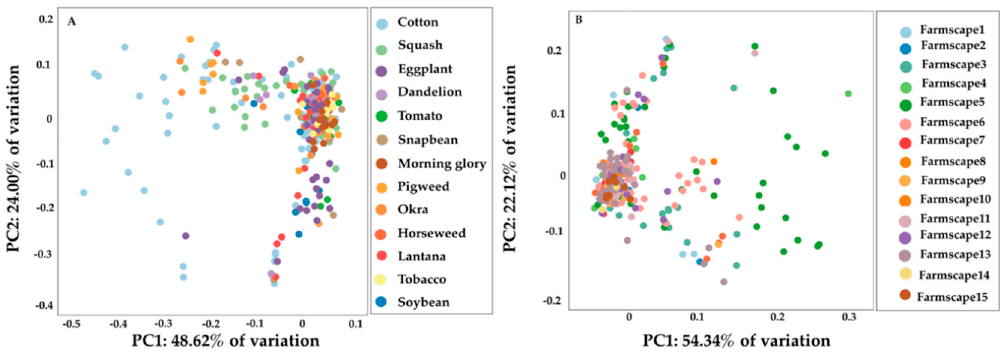
Figure 5. Population structure based on principal component analysis for B. tabaci MEAM1 populations collected from different host plants ( A ), and farmscapes ( B ). Dots represent single individuals within the populations. All individuals are clustered together indicating minimum genetic isolation between individuals.